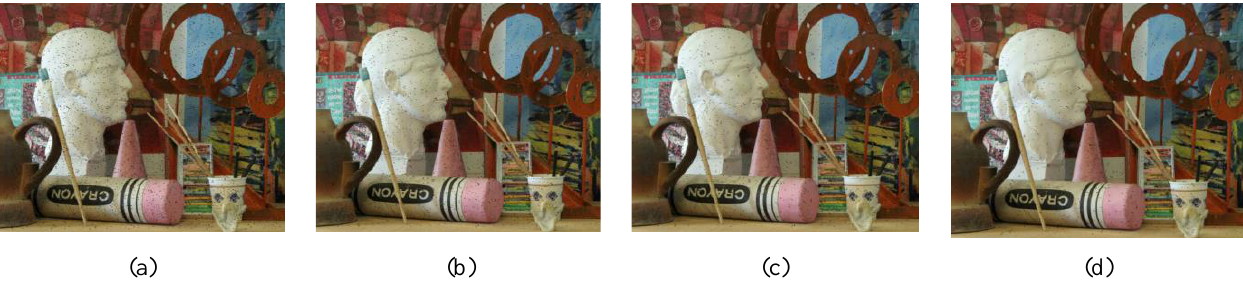
Figure 8. Virtual view synthesis by different methods for "Art" (a) used in [18] (b) used in [5] (c) used in [14] (d) used in [15] . Table 6. Objective measures of virtual view by different methods for "Art". Methods